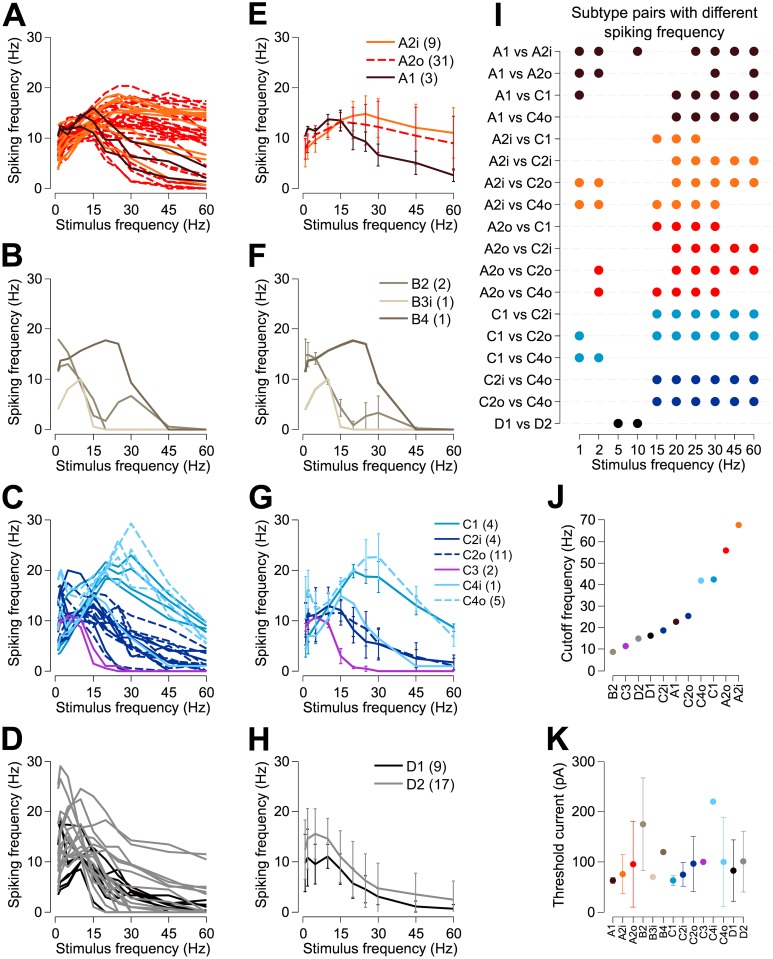
Frequency response of retinal ganglion cells.Panels (A–D) show the recorded frequency response of each recorded cell grouped by morphological cell type (A, A-type; B, B-type; C, C-type and D, D-type). Panels (E–H) show the frequency response of each morphological cell type, averaged across all recorded cells of each type. Error bars indicate plus/minus one standard deviation. These data are summarized in panel (J), which shows the 3 dB cut-off frequency for each morphological cell type for which at least two cells were recorded. Panel (I) summarizes the significant differences between morphological cell types at each stimulation frequency (t-tests, p < 0.05). (K) Mean threshold currents for 10 Hz sinusoidal stimulation for each cell type. Error bars indicate plus/minus one standard deviation. The cell counts for each morphological cell type are indicated in parentheses in the figure legends.